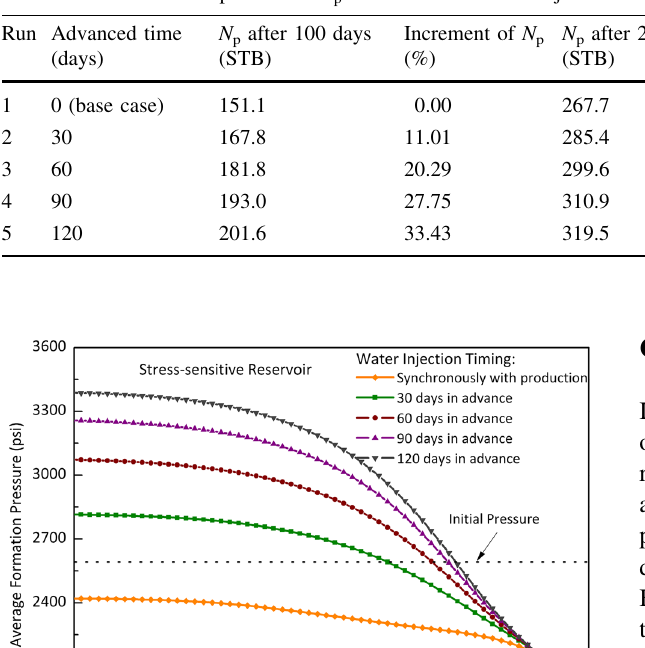
Table 3 Cumulative oil production N p under different water injection timing